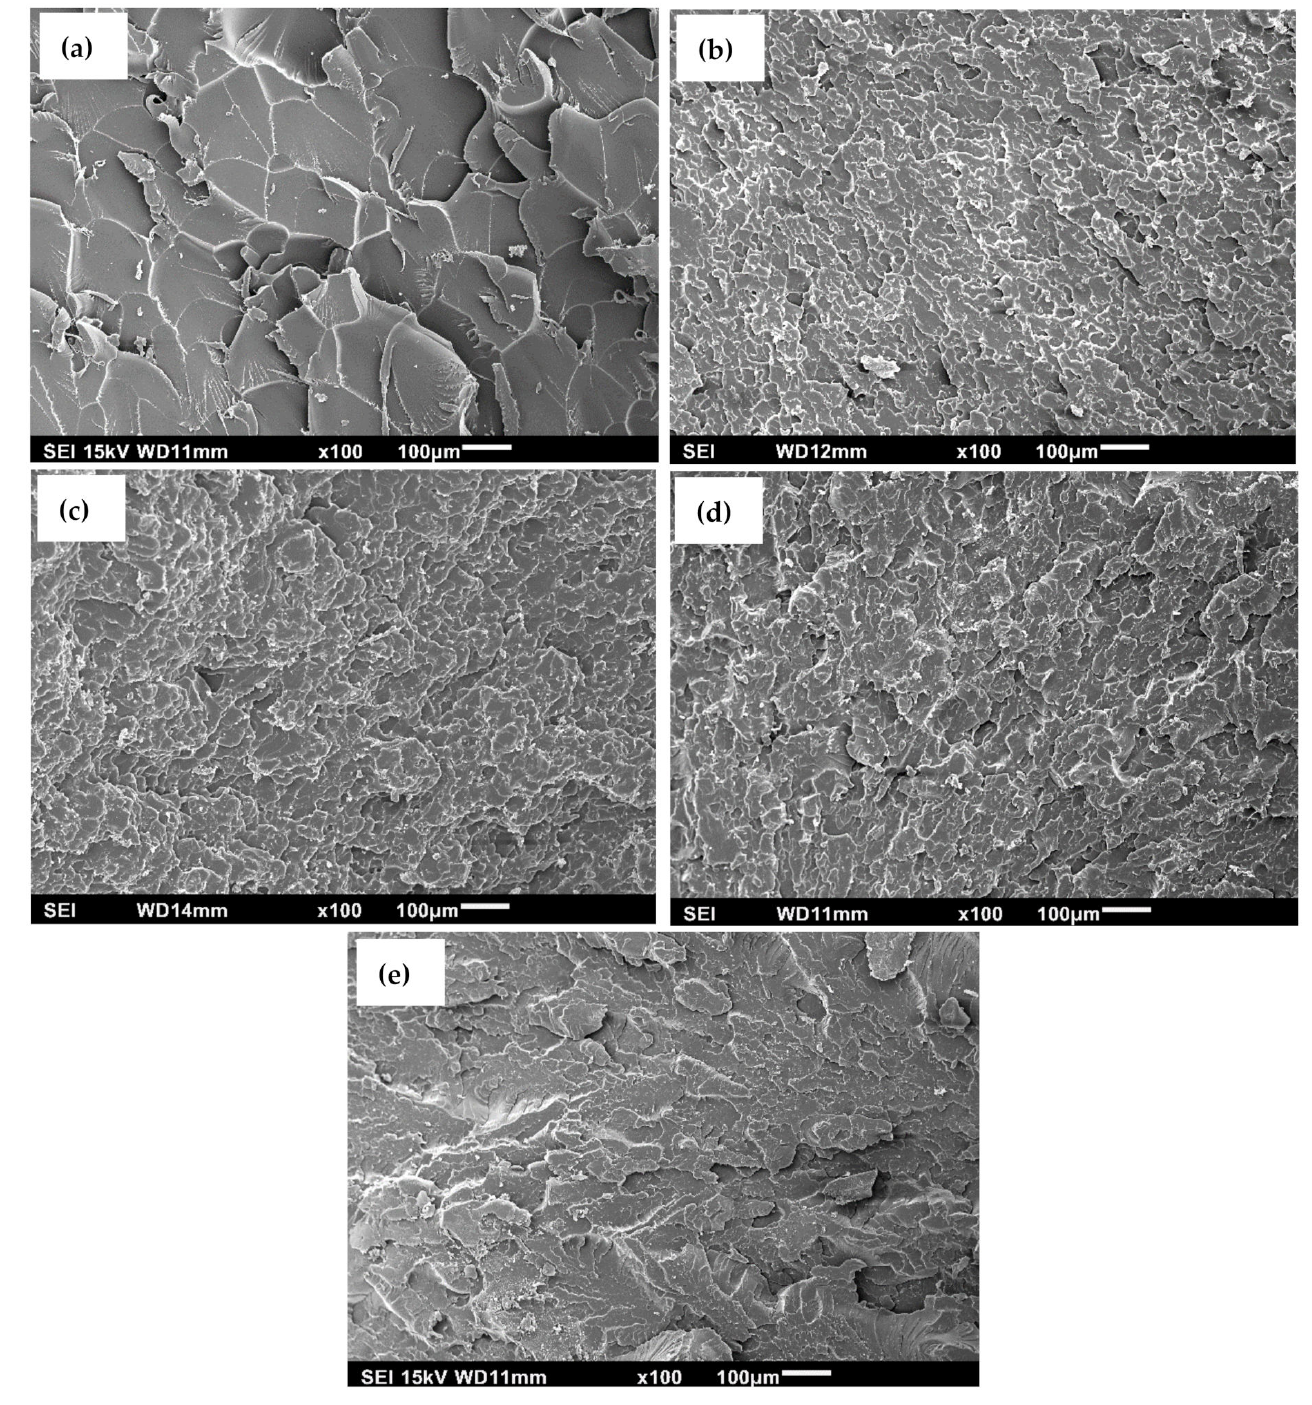
Figure 6. SEM images of fractured tensile surfaces of ( a ) pure bio-epoxy; ( b ) bio-epoxy/0.1 wt.% GO; ( c ) bio-epoxy/0.2 wt.% GO; ( d ) bio-epoxy/0.3 wt.% GO and ( e ) bio-epoxy/0.6 wt.% GO